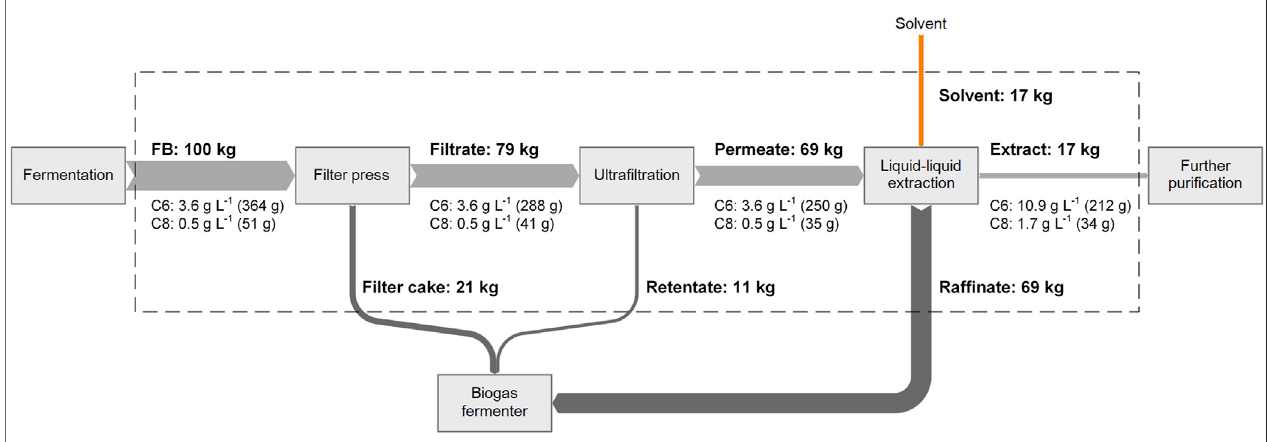
FIGURE 7 | Overall mass balance of the downstream processing cascade including caproic (C6) and caprylic acid (C8) concentrations (FB: fermentation broth).